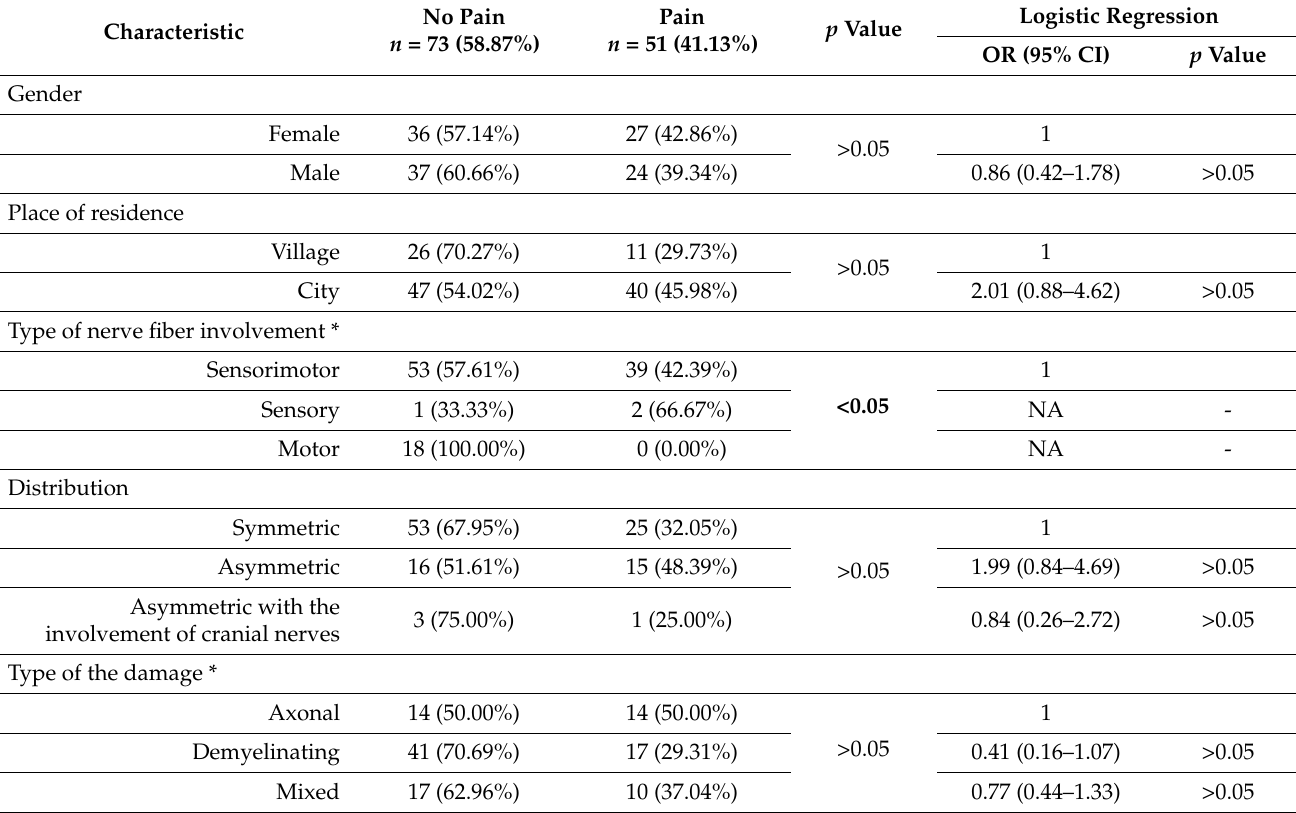
Table 2. Summary of demographic and clinical parameters of patients with and without